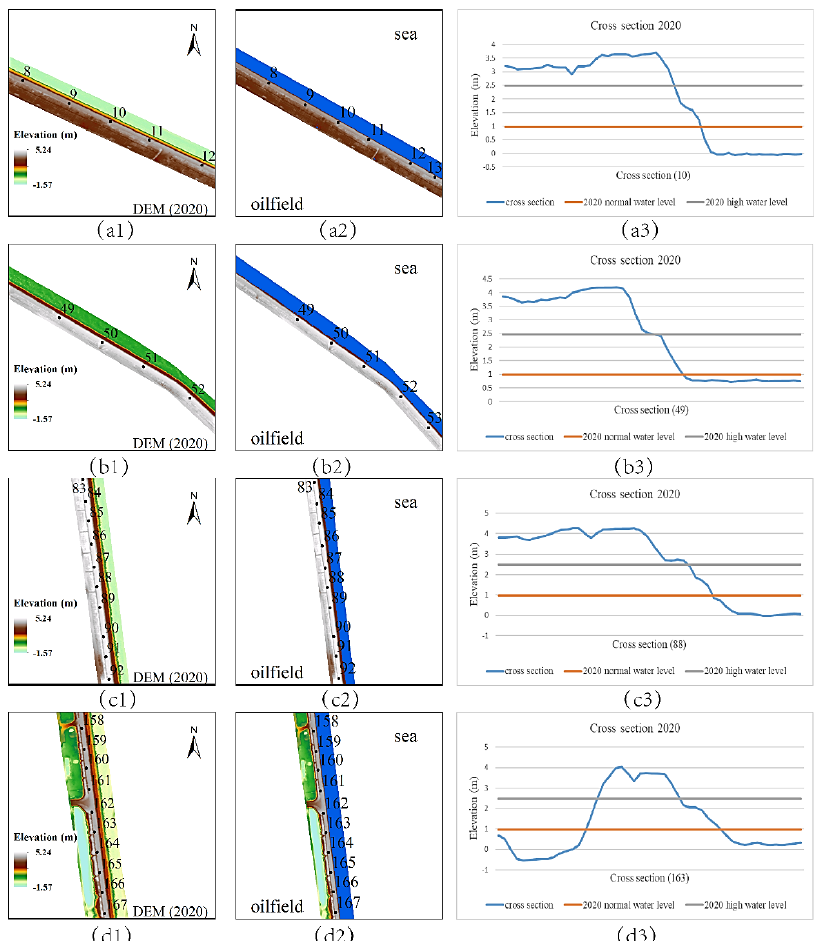
Figure 25. Cross section of the dam and 2D inundation diagram for 2020. The first column shows the DEM of four different part of the dam in 2020, and the second column indicates the inundation range of the dam, due to the high sea-level (2.48 m) shaded in blue. The third column represents a cross section of the dam at Points 10, 49, 88 and 163, in which the right direction is